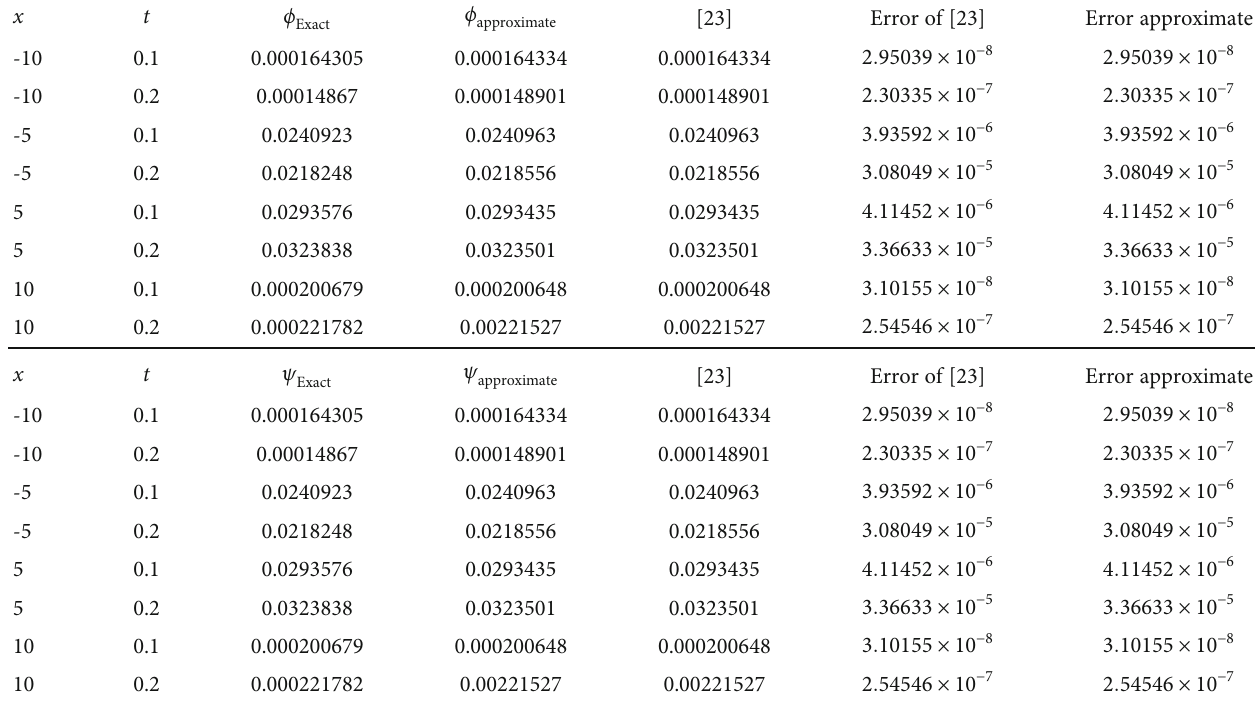
Table 2: Numerical outcomes of the exact and approximate solutions and the results obtained in